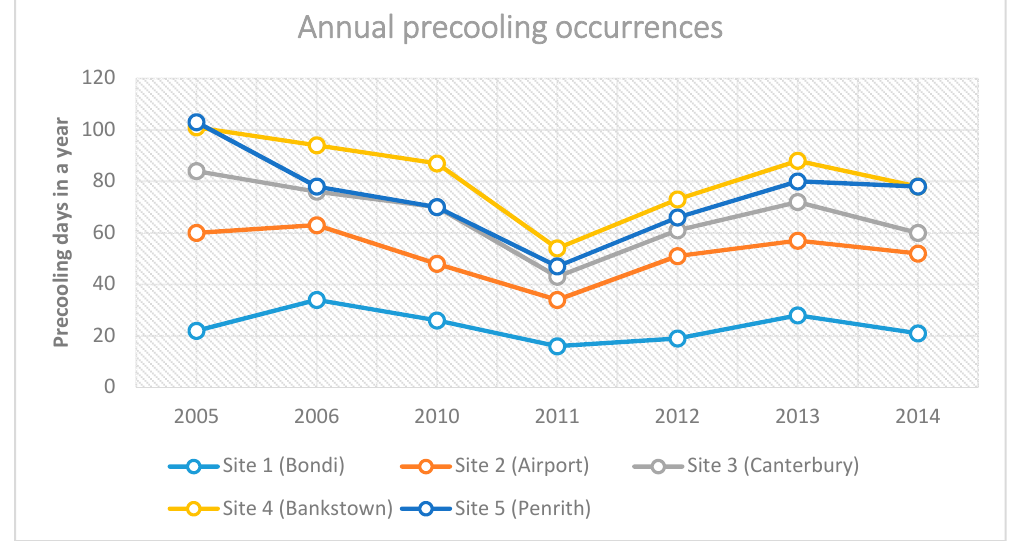
Figure 3. Number of days that precooling conditions were met per year for each sites.